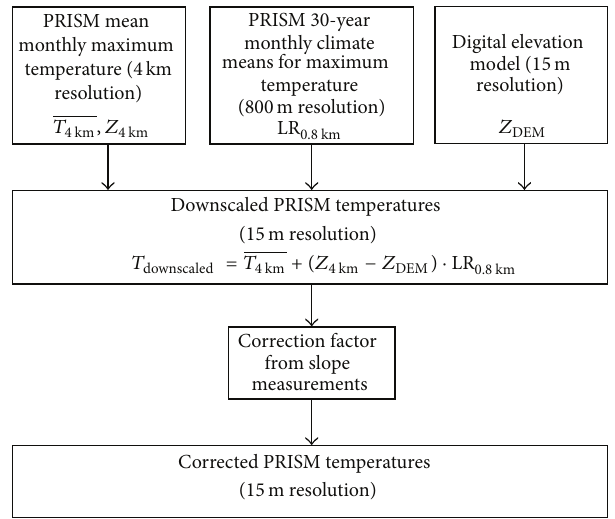
Figure 1: Summary of our downscaling method in which we downscale the monthly 4 km mean monthly maximum PRISM ) to a 15 m resolution DEM based on the lapse temperature ( 𝑇 4 km ratesderivedfromthe800 mPRISM30-yearmonthlyclimatemeans ) for maximum temperature over the period 1971–2000 (LR 0.8 km and the difference between the mean elevation of the 4km grid ) and elevation of each 15 m grid cell ( 𝑍 ) to obtain box ( 𝑍 4 km DEM ) at a 15 m resolution. We then downscaled PRISM ( 𝑇 Downscaled based on the slope temperature apply a correction to 𝑇 Downscaled measurements to obtain more realistic, high-resolution estimates of temperature in Shenandoah National